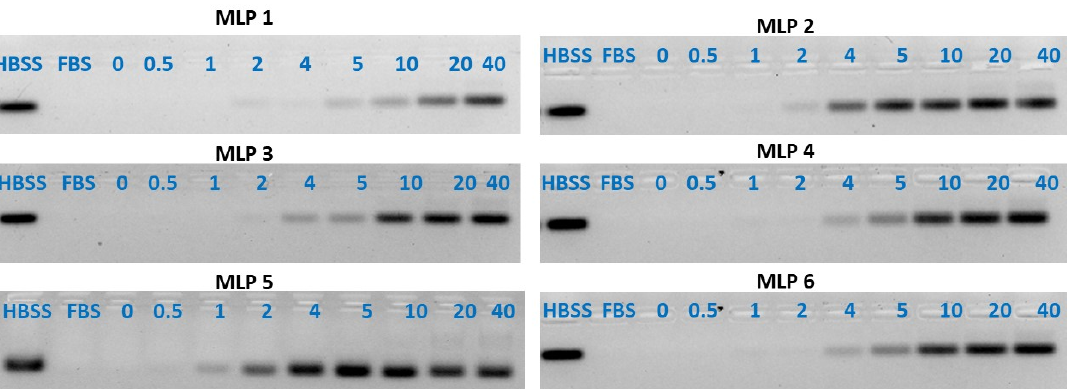
Figure 6. Serum stability of siRNA after complex formation with peptides. Heparin sulfate dissociated siRNA from the peptide/siRNA complexes (FBS 25%, incubation time 24 h). The band representing the negative control (scrambled siRNA exposed to saline for 24 h at 37 °C) was quantified as 100%. Data are presented as the average of triplicate samples, and the error bars represent standard deviation. ns = non-significant. The bands were quantified using Image Lab software version 6.0.1.